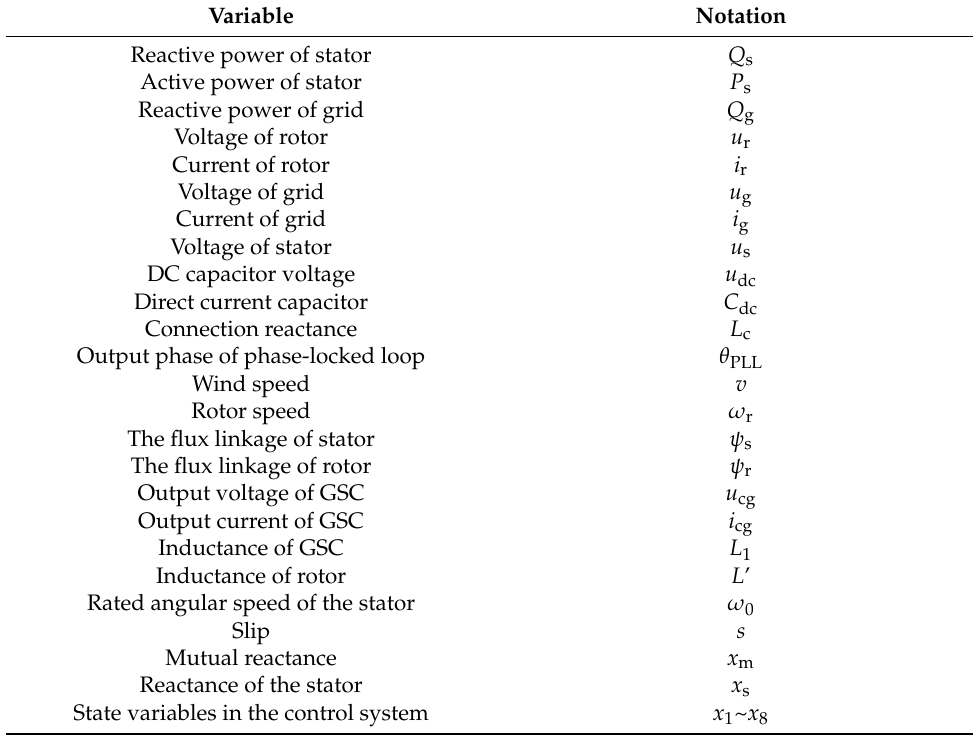
Table A1. The definitions of variables for the DFIG.